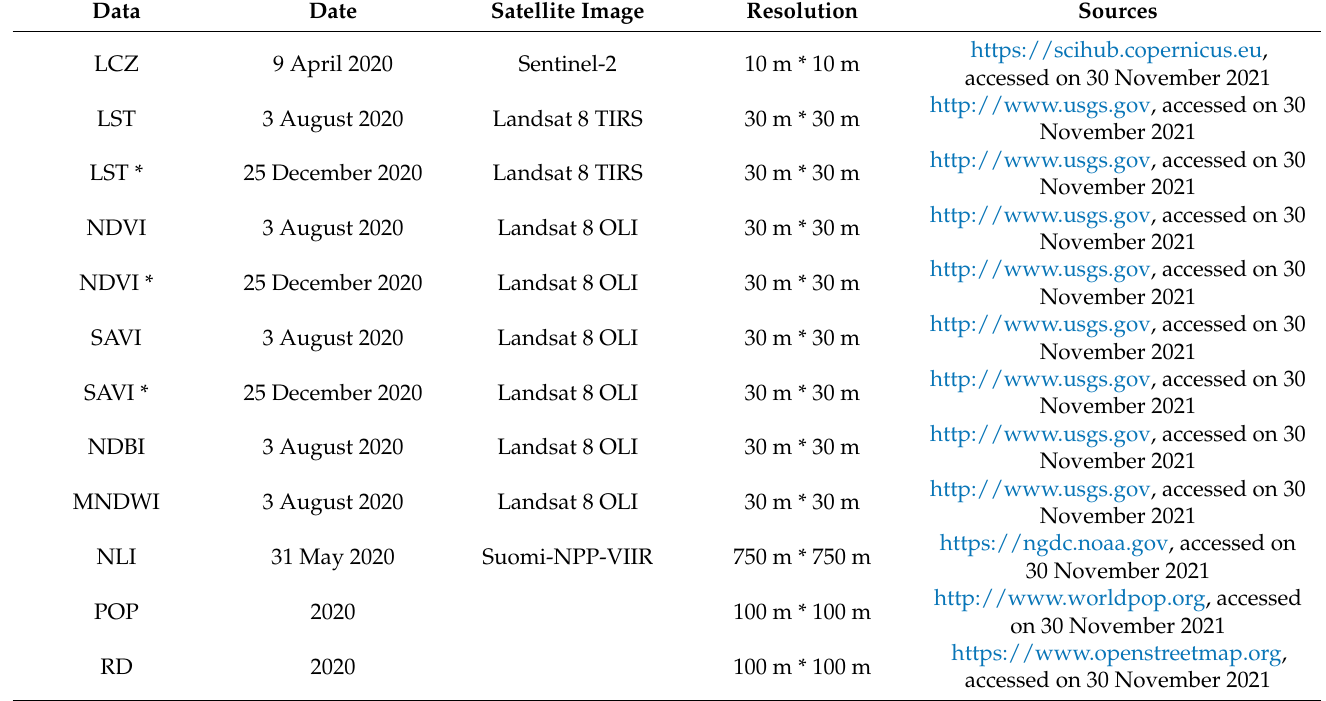
Table 1. Data description in this